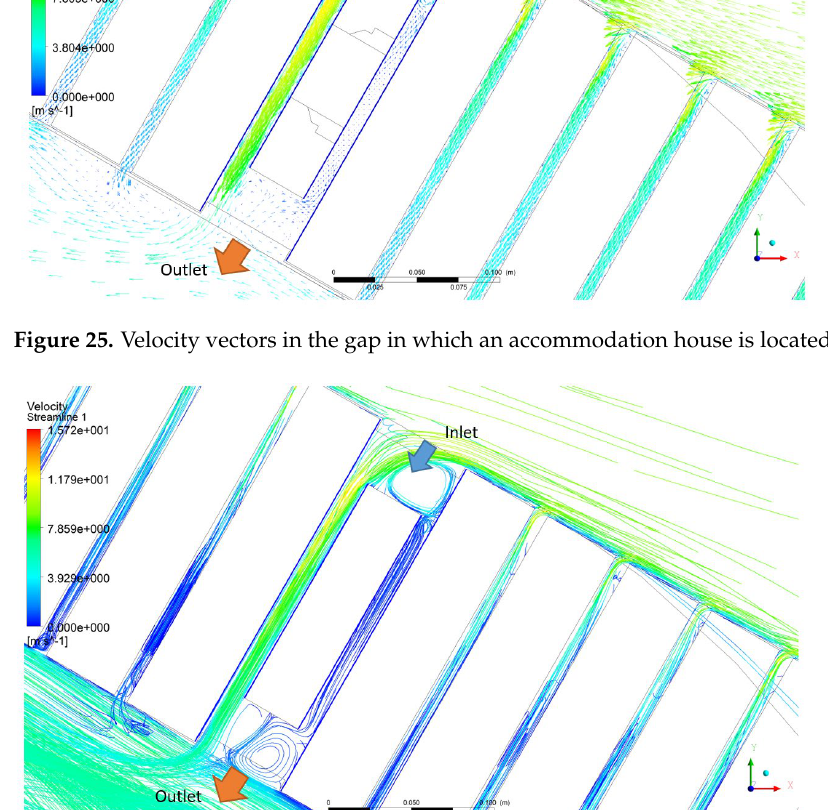
Figure 26. Streamlines in the gap at an accommodation house.